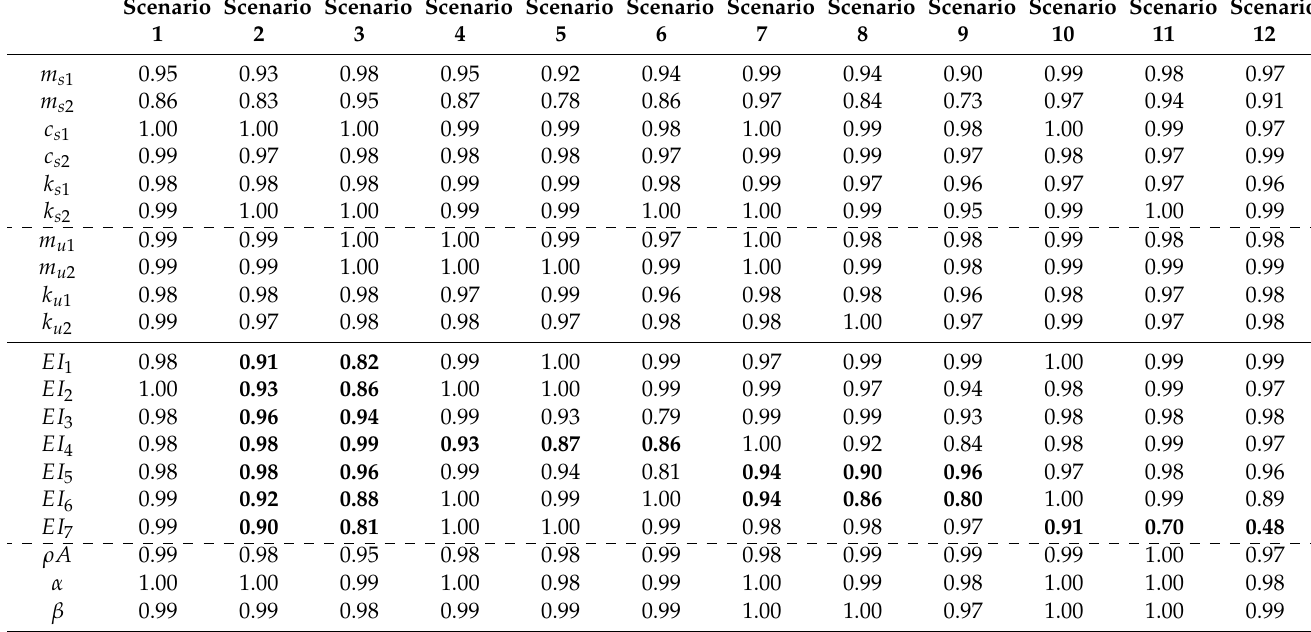
Table 8. The estimation accuracy of the mechanical parameters by the PRE method: When the average of estimated EI i is shown in bold style, this indicates that the element i has reduced